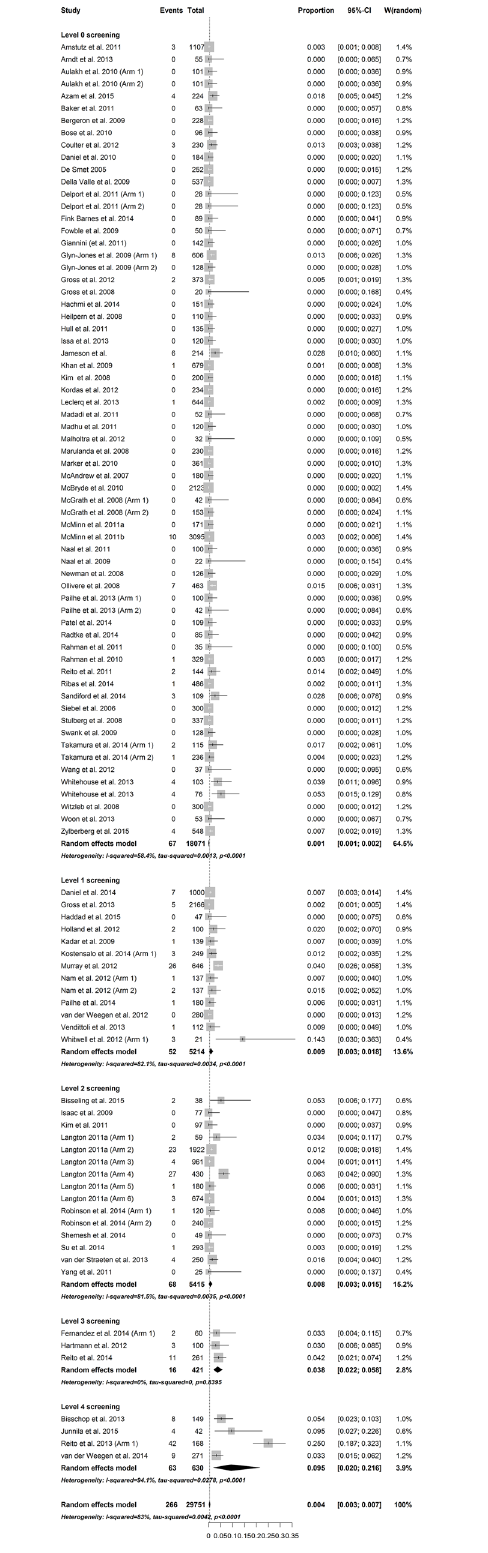
Fig 2. Forest plot of prevalence of ARMD in the HR group stratified by level of screening.